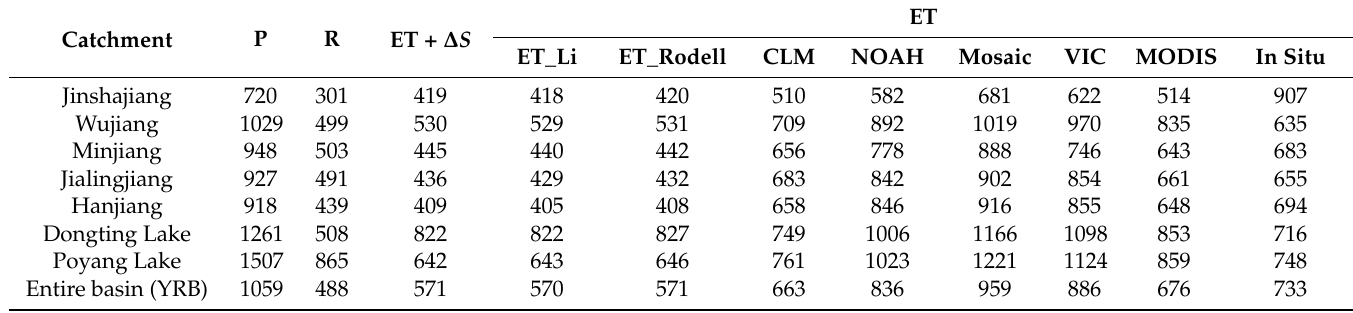
Table 3. Mean values of annual P , R , ET + ∆ S , and ET based on different methods for the seven subcatchments and the entire YRB.